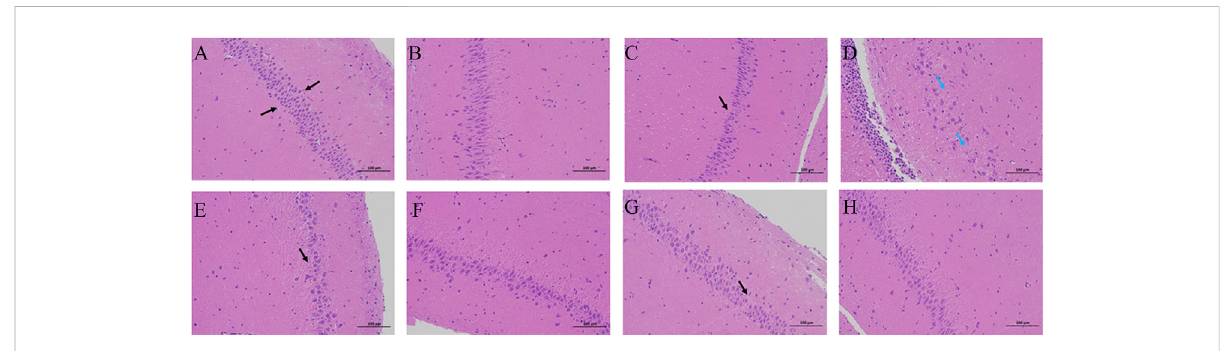
FIGURE 4 H&E staining in the therapeutic effect of AR against AD with a microscope. (A,C,E,G) the hippocampus CA1 of CN, AD, LD, and HD group (B,D,F,H) the hippocampus CA3 of CN, AD, LD, and HD